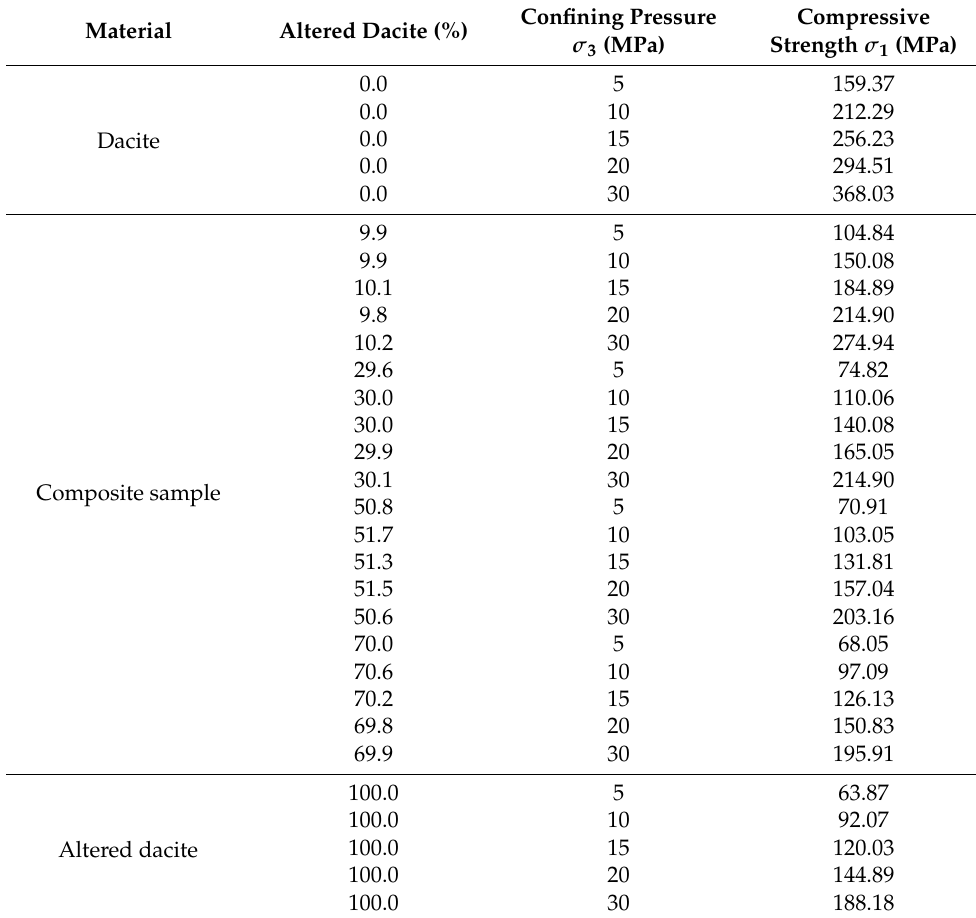
Table 2. Test results of triaxial compressive strength.